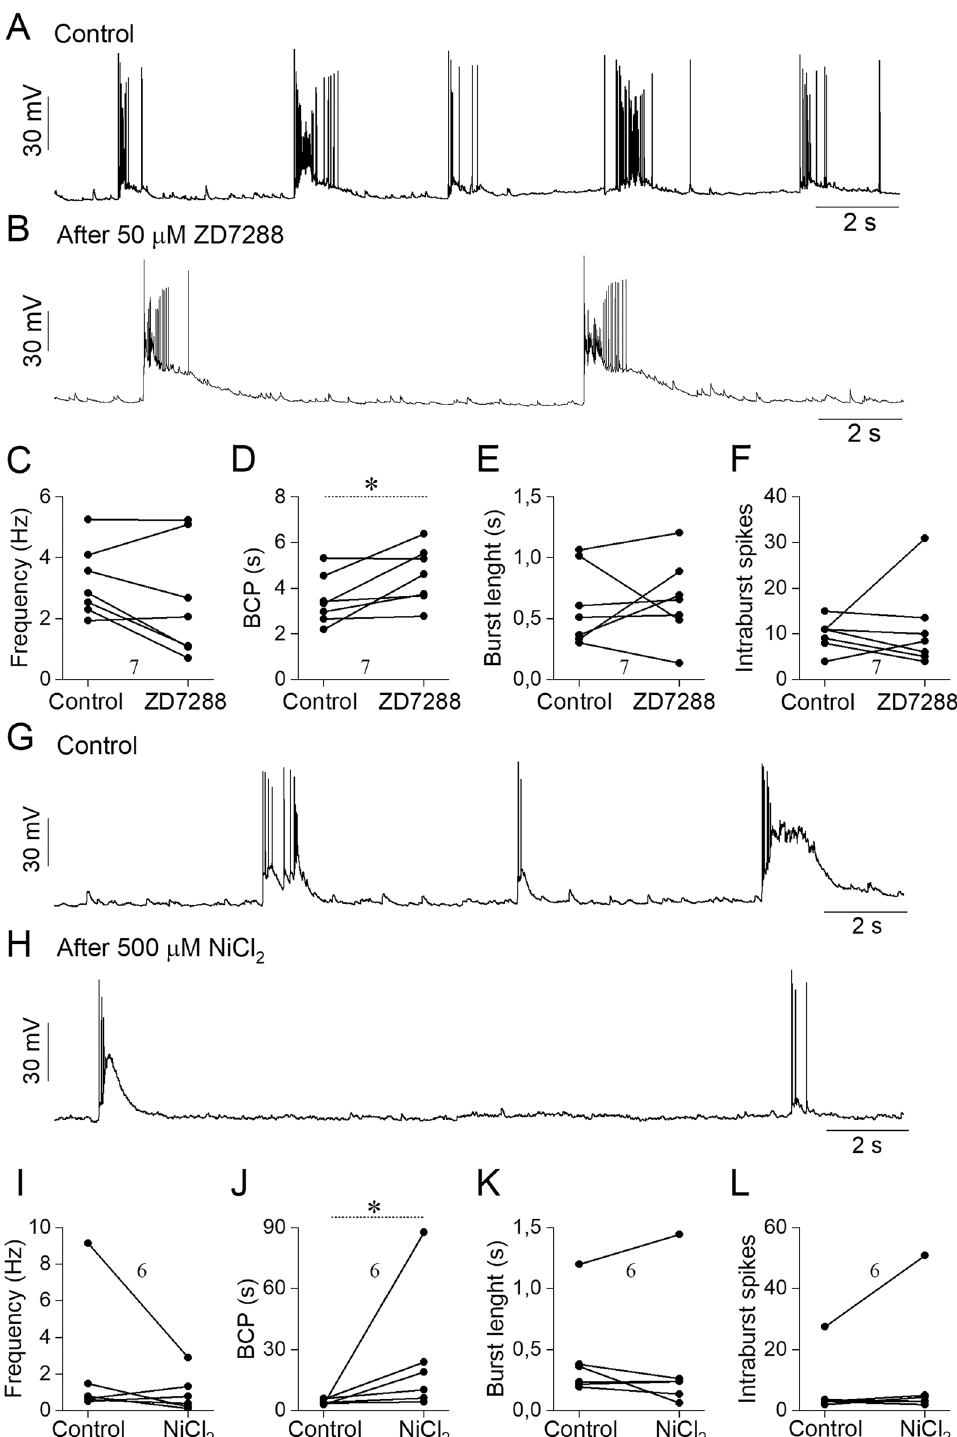
Figure 7. HCN and T-type calcium channels are involved in the increased bursting activity during homeostatic upscaling. Spontaneous firing activity was registered from the same TTX-treated neuron before ( A ) and after ( B ) the HCN channel blocking (50 μM ZD7288). Blocking of the HCN channels does not affect firing frequency ( C ), burst length ( E ) or the number of intraburst spikes ( F ), but significantly increases the burst cycle period (D ). Representative figures ( G , H ) show the T-type calcium channel-dependent effect on the firing activity during TTX treatment. Blocking of the T-type calcium channels by 500 μM NiCl 2 significantly decreased the bursting activity ( J ), but did not change the firing frequency ( I ), the burst length ( K ) or the number of intraburst spikes ( L ). Data are representative of three independent cultures. The number of cells analyzed is indicated above or below data in the graphs. Statistical analysis was performed with paired sample t-test (*p <